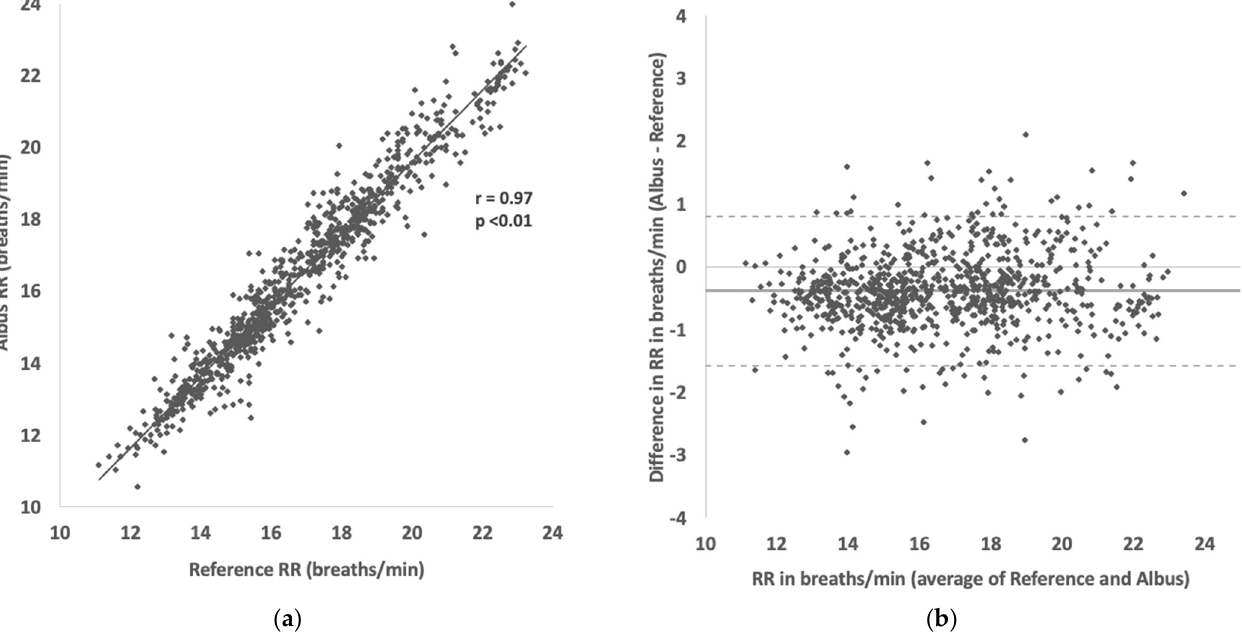
Figure 2. ( a ) Scatter plot showing correlation between RR readings between Albus system and reference (clinician-counted polygraphy). ( b ) Bland–Altman plot showing agreement in RR readings between Albus system and reference (solid line shows mean difference of − 0.38 breaths/min and dotted lines show 95% limits of agreement from 0.8 to − 1.6 breaths/min). There are, in total, 900 comparisons across 32 participants, with each point depicting a RR reading for a 30-s period.